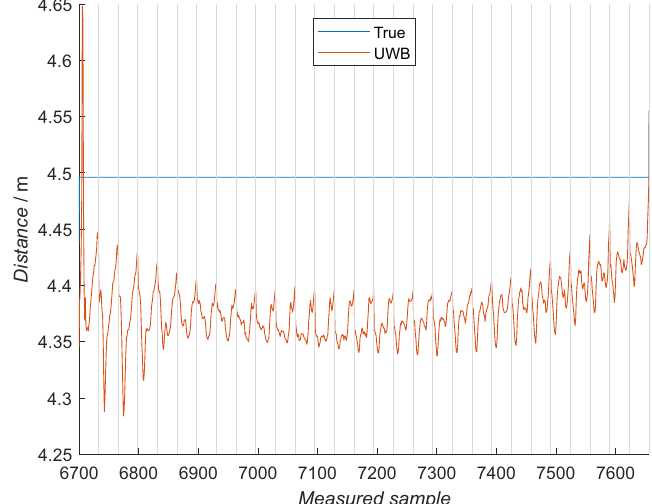
Figure 13. Exemplary set of zoomed training data for measurements at 4.5 m, where a mean of 250 samples is presented for each azimuth and elevation point. Each gray compartment represents one azimuth sweep at a constant elevation, meaning the elevation is changing from − 70 degrees on the left to the 70 degrees on the graph’s right-hand side. In each compartment, the azimuth goes from − 80 degrees on the left-hand side to 80 degrees on the right-hand side. The blue line represents the reference distance.